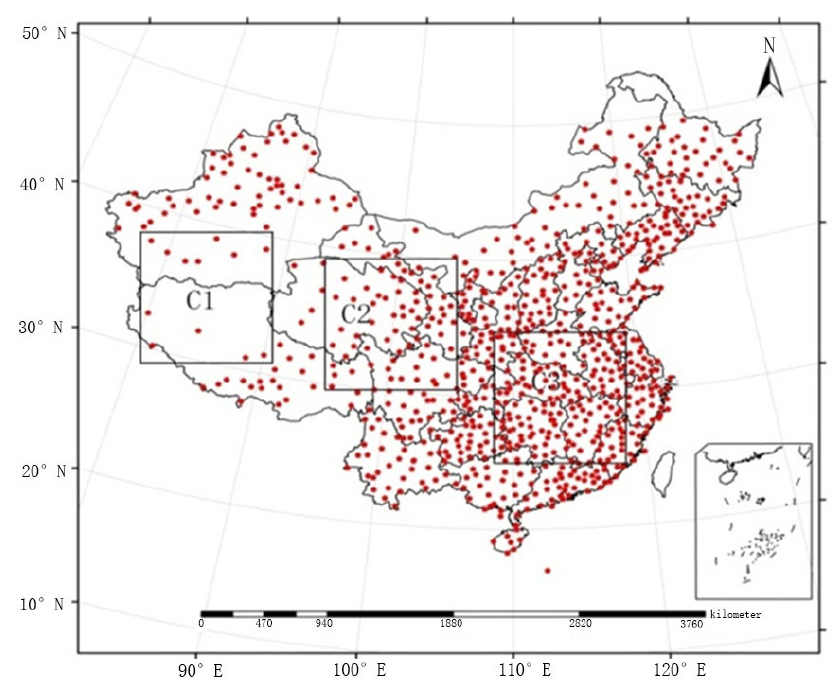
Figure 1. Distribution map for the automatic weather stations in regions C1, C2, and C3.